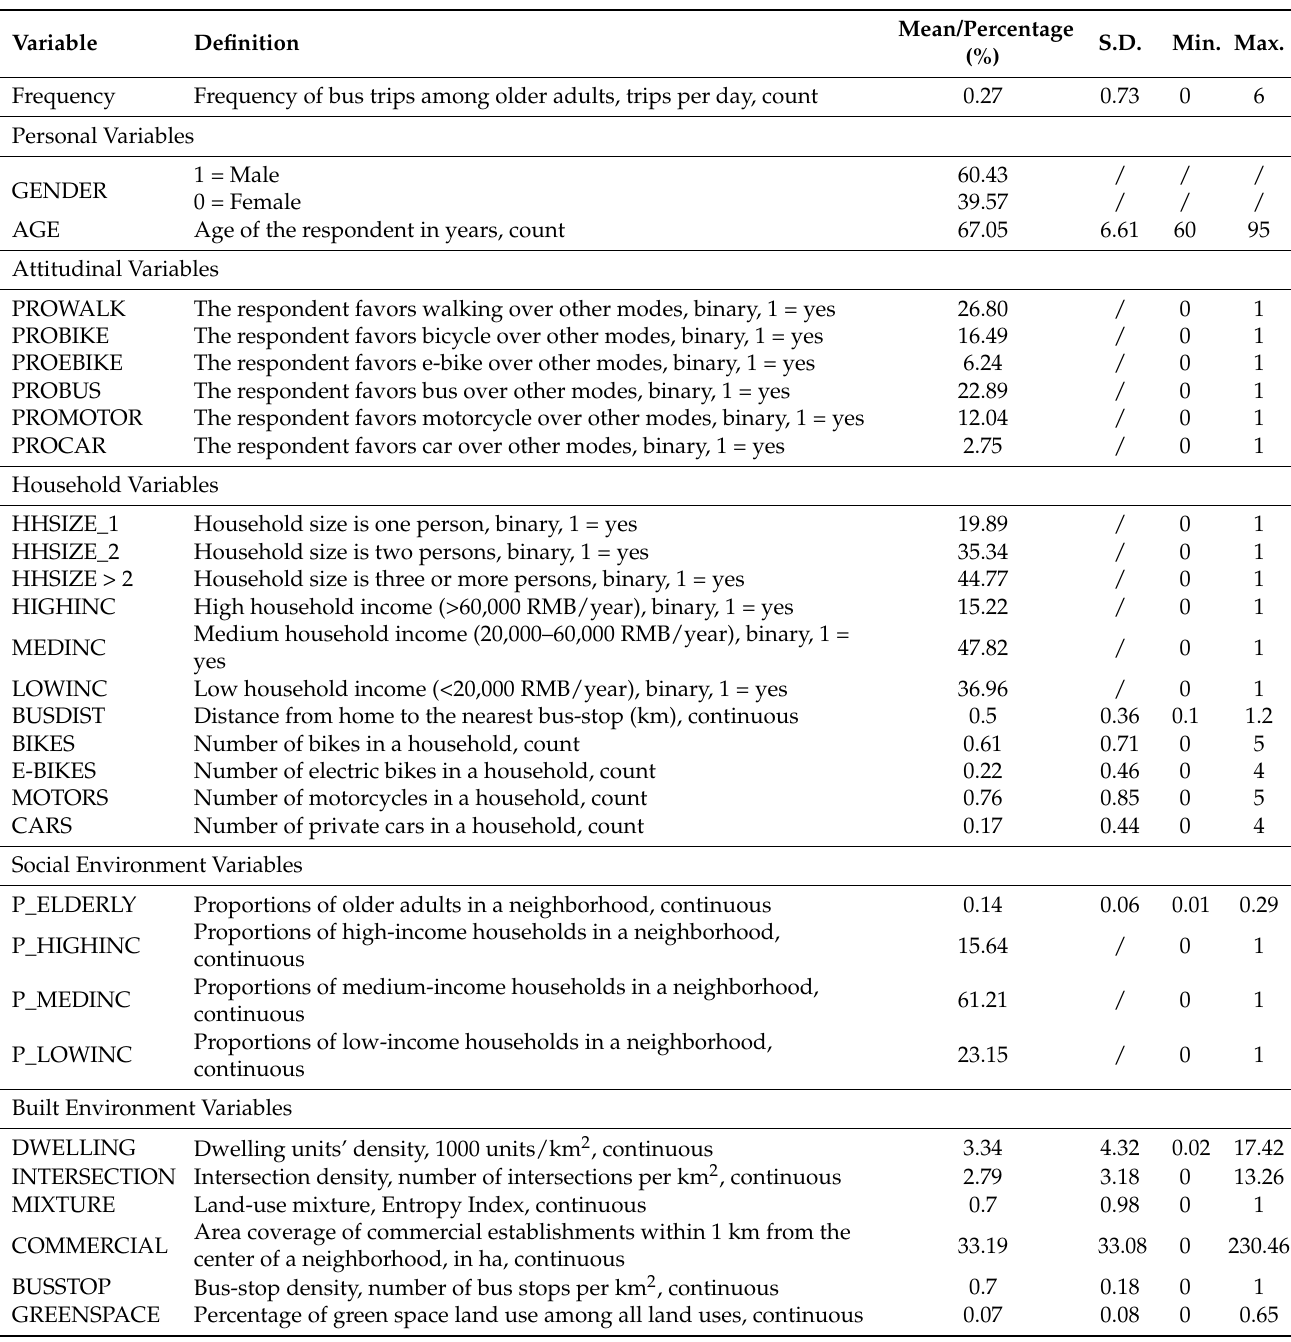
Table 3. Definition and descriptive statistics of